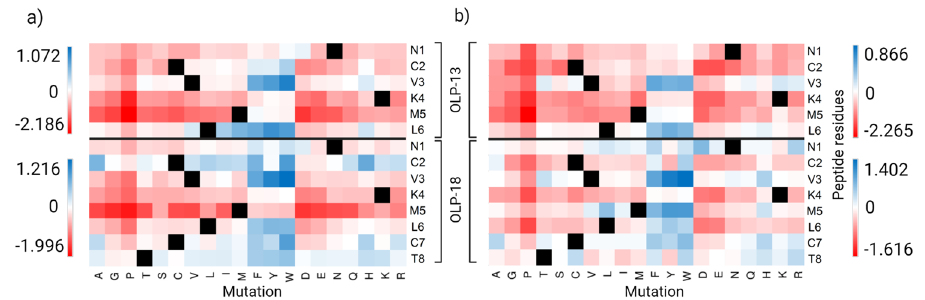
Figure 6. Heat maps representing in silico saturation mutagenesis analysis of OLP-13 and OLP-18 inhibitory peptides. (a) OLP-13-nsp16 and OLP-18-nsp16 interactions, and (b) OLP-13-nsp14 and OLP-18-nsp14 interactions. Mutations with improving (positive ΔΔGAffinity) and decreasing (negative ΔΔGAffinity) impacts on the peptide-target binding affinity are shown in blue and red,